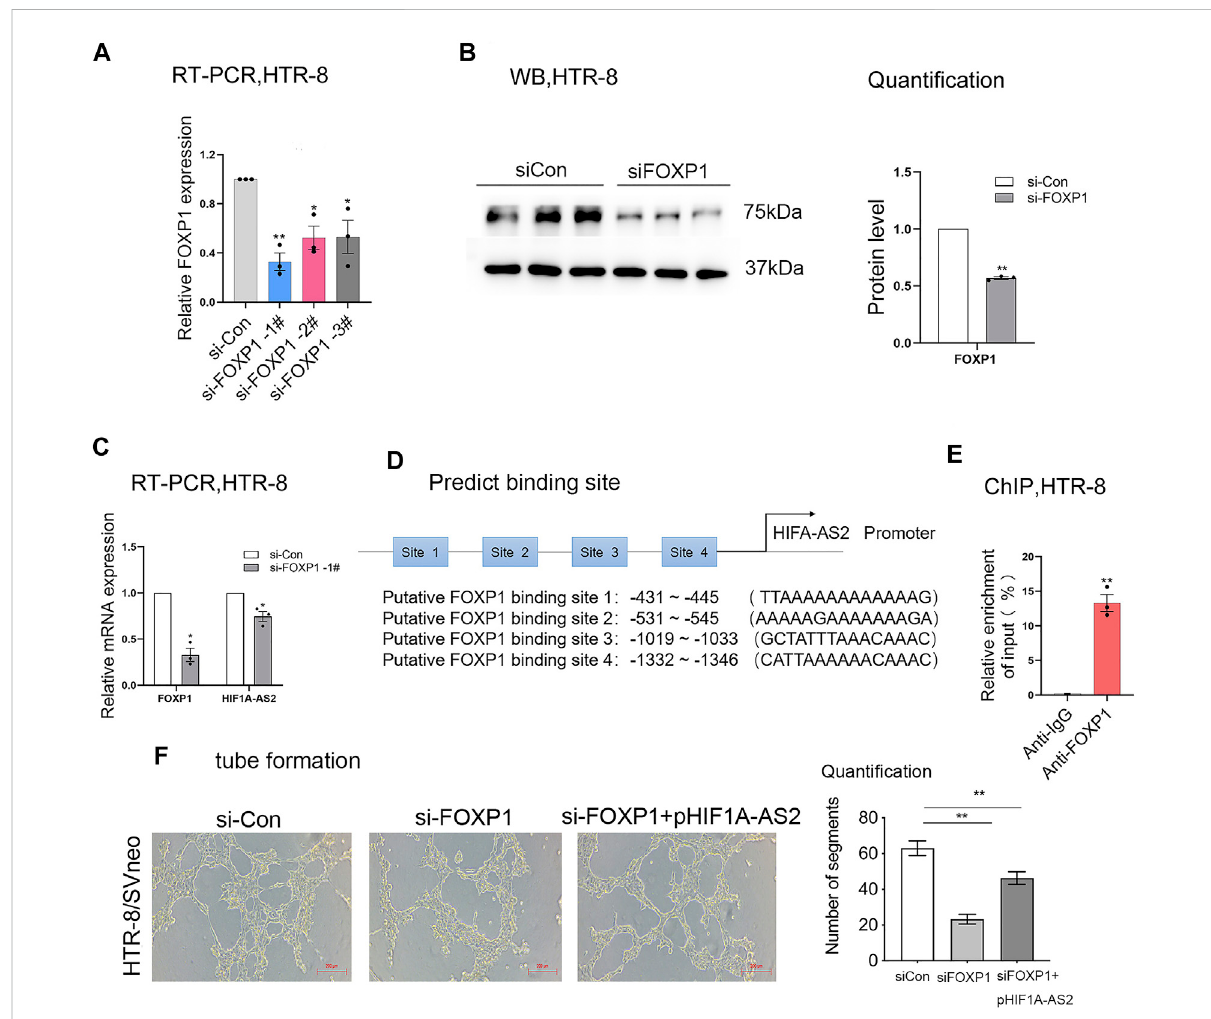
FIGURE 4 HIF1A-AS2 interacts with the transcription factor FOXP1. FOXP1 expression level was detected at RNA and protein level by qPCR (A,C) and Western blotting (B) , respectively, after FOXP1-speci fi c siRNAs were transfected into HTR-8/SVneo. After the treatment with siRNAs against HIF1A- AS2, thelncRNAexpressionwastestedbyqPCR (C) .TheputativebindingsitesofFOXP1on HIF1A-AS2 promoterregion,andfourpotentiallyrelevant bindingsequenceswereacquiredbyusingtheJASPARwebsite (D) .ChIPassaycon fi rmedthebindingofFOXP1tothepromoterof HIF1A-AS2